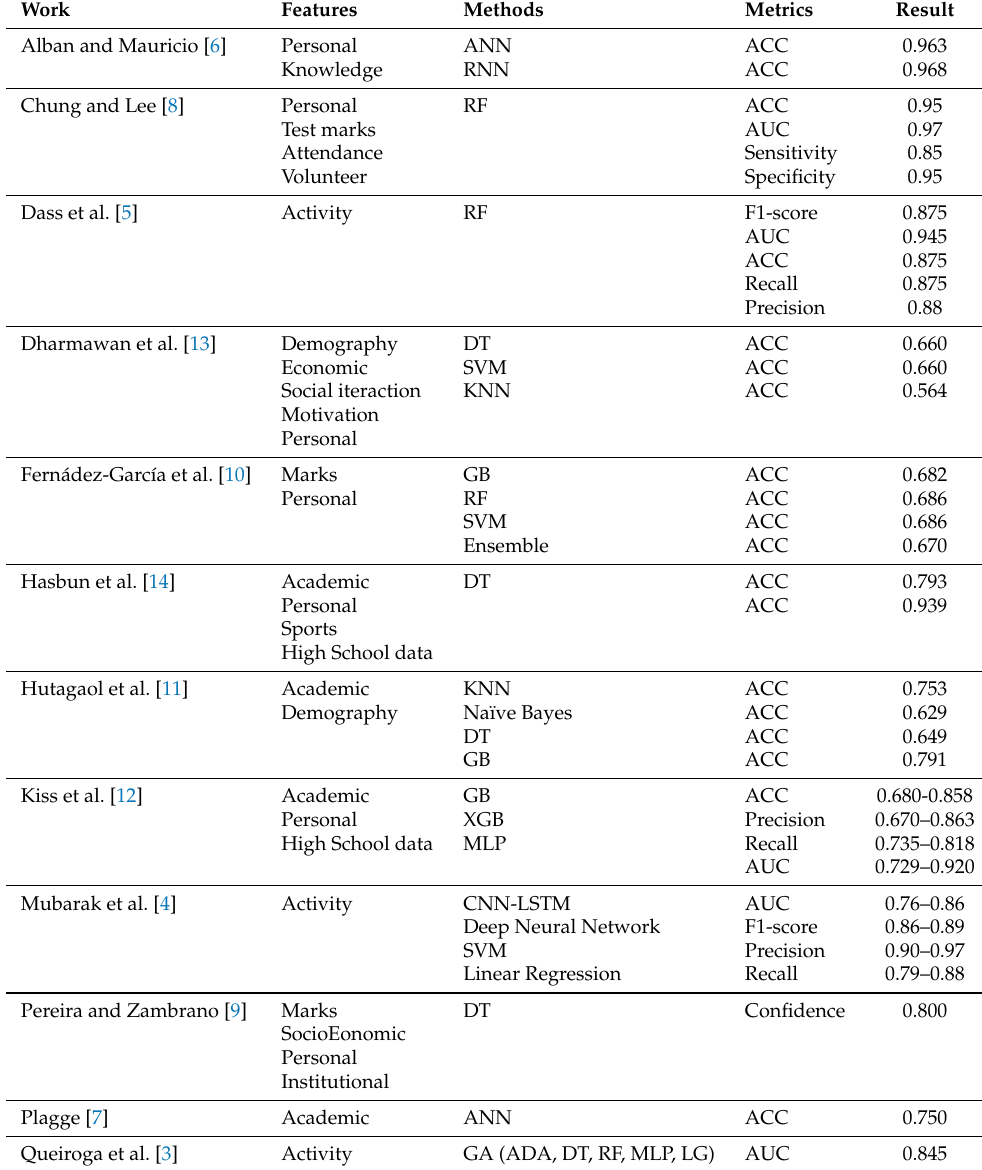
Table 1. Model, features, and metrics used and results